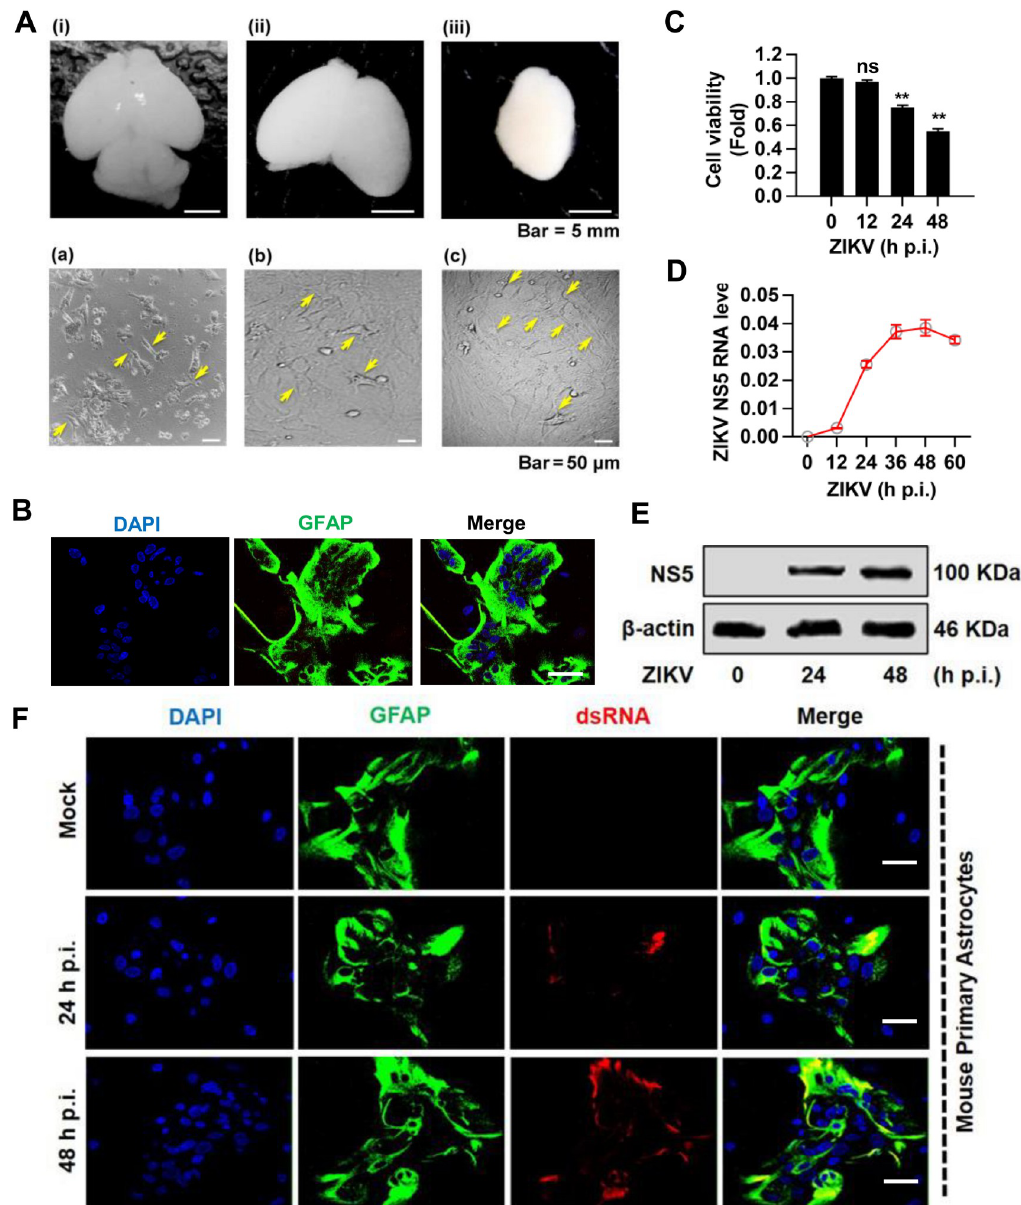
Fig 1. The isolation, culture, and identification of ZIKV infection in mouse primary astrocytes (MPAs). (A) Postnatal (P3) mouse dissection for cortical astrocytes isolation. (i) Whole brain; (ii) Brain after cerebellum and olfactory bulbs removal; (iii) Cortices isolation by peeling off the meninges, a plate-like structure on the brain cortex, scale bar 5 = mm. Culture of mouse primary astrocytes from mouse brain cortex. (a) The yellow arrows indicate single cell astrocytes attached to the bottom of the culture flask and floating are the dead neurons in supernatant. (b) Astrocytes layer is forming and confluent after vigorous shaking to remove OPCs and Microglia cells. (c) Primary astrocytes layer shows a high density of the cells after 2 weeks of the first split, scale bar = 50 μ m. (B) Identification of mouse primary astrocytes with rabbit anti-GFAP (green) marker and DAPI (blue) for nuclei by confocal microscopy, scale bar = 20 μ m. (C-F) MPAs were mock-treated or infected with ZIKV (MOI = 2) for indicated times. Cell viability was measured by CCK8 assay (C) , ZIKV viral NS5 mRNA (D) and NS5 protein expression ( E ) were determined by qPCR with GAPDH as an internal control and Western blot with β -actin as internal control, respectively, and viral dsRNA (a replication intermediate) was immunoprobed with dsRNA-antibody (red), along with GFAP (green) for astrocytes and DAPI (blue) for nuclei by Immunofluorescent (IF), scale bar = 20 μ m (F) . The underlying numerical data for “Fig 1C and 1D” is provided in the supporting file “S1